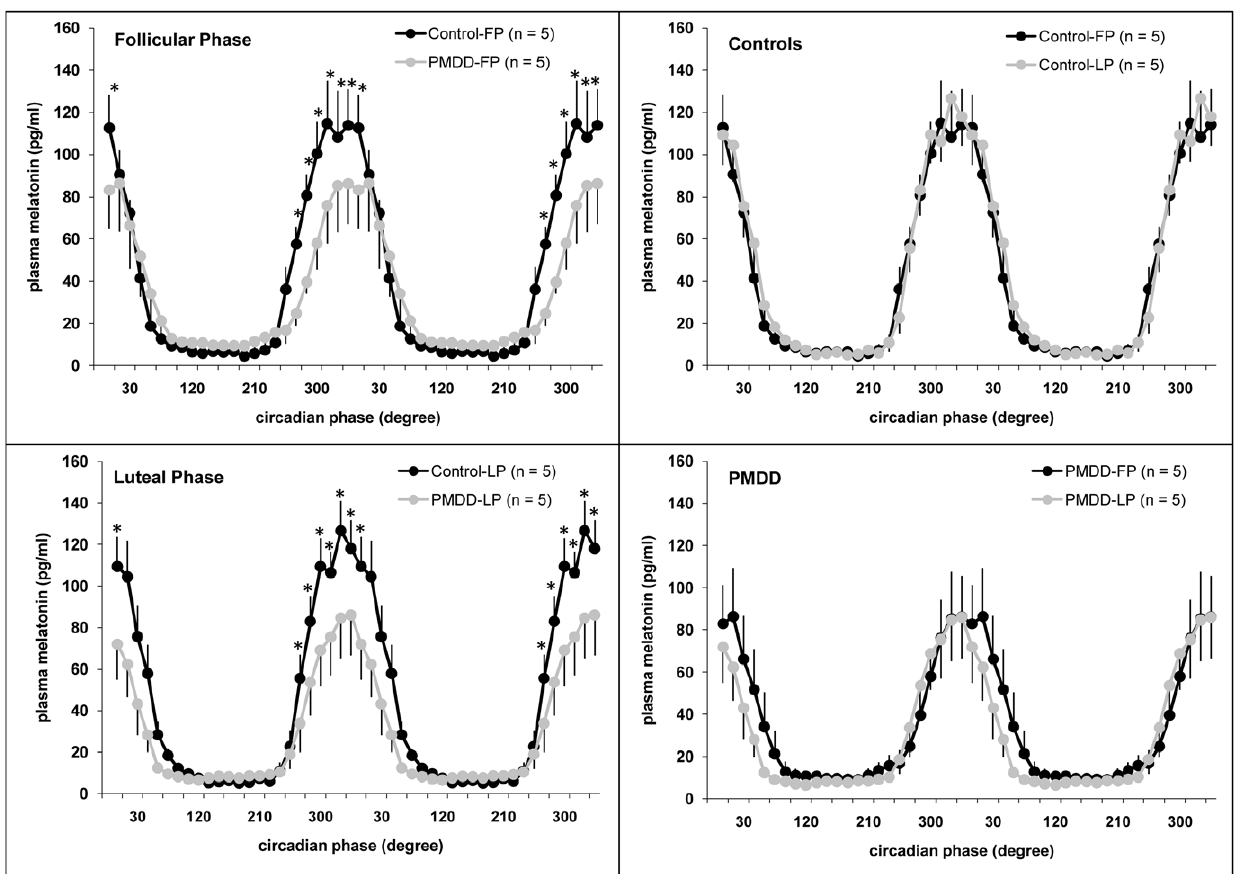
Figure 1. Circadian variation of plasma melatonin during the follicular and luteal phases in PMDD women and controls. * indicates significant differences between controls and PMDD women (P , .05). Data are double-plotted for illustration purposes. Values are mean 6 SEM.